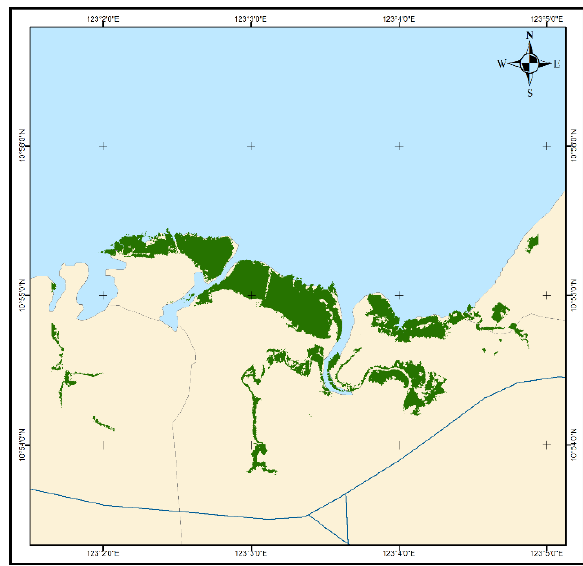
Figure 5. The final classified image of Victorias City, Negros Occidental. Final classes include Water, No Data, Short Vegetation, Fallow, Sugarcane (SC3), Other Trees (OTr), Built- up (Bu) and Mangroves (Mgr) During editing, orthophotos and exported shapefiles were viewed to check for accuracy. Manual classification was done to reclassify dead mangroves as water since they are classified as built-up. Also, manual classification was done in the edges of mangroves patches that were classified as built-up due to shadows affecting the classification. The same was done in the borders of the data where heavy triangulation is common. The resulting map of the mangrove extraction in one of the processed coastal area of the municipalities/ cities of Negros Occidental is seen in Figure